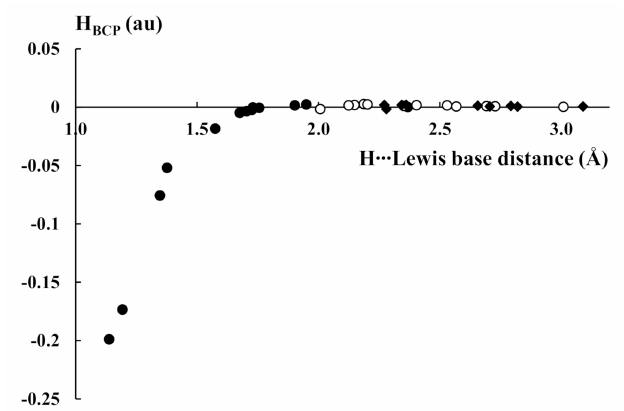
Figure 2. The dependence between the H ··· Lewis base distance (between H-atom of the proton donor and the centre of Lewis base unit, in Å) and the total electron energy density at BCP, H BCP for hydrogen bonded systems. The Lewis base centre is an atom for 3c–4e A-H ··· B hydrogen bonds (black squares for C-H ··· B hydrogen bonds and black circles for other 3c–4e systems) and it is BCP of CC bond or C-atom in Lewis base unit for the A-H ··· π hydrogen bonds (while